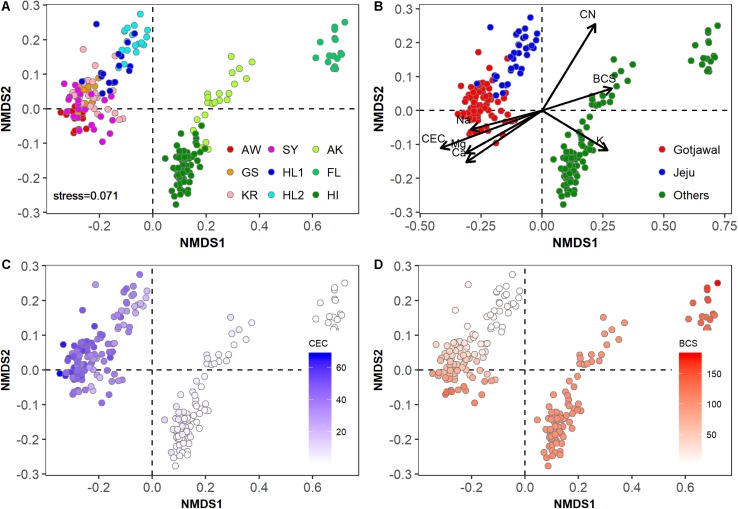
Non-metric multidimensional scaling (NMDS) plot showing physicochemical properties in soil samples in this study (k = 2; stress = 0.0741). (A) Individual sampling points, (B) four regions (AW, KR, GS, and SY) of Gotjawal: Gotjawal, Non-Gotjawal forest on Jeju Island (Jeju), and other regions (Others), (C,D) concentrations of CEC and BCS are indicated by the color gradient from white to blue and red, respectively. The soil properties indicated by arrows in (B) are the significant properties (p < 0.05) contributing to each ordination.